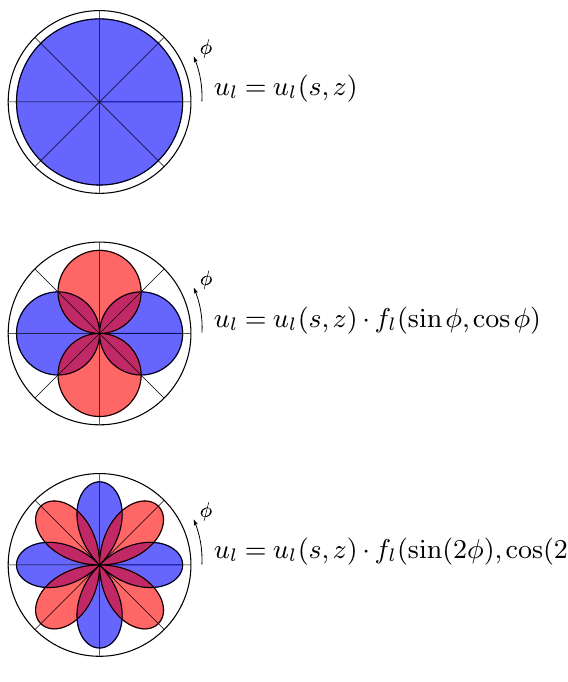
Figure 2. Radiation patterns for monopole (top), dipole (middle), and quadrupole angular orders of the respective moment tensor ele- ments. The azimuthal radiation patterns encapsulated by f l depend on multipole order m as well as component l , that is, no summation is implied by the above products.